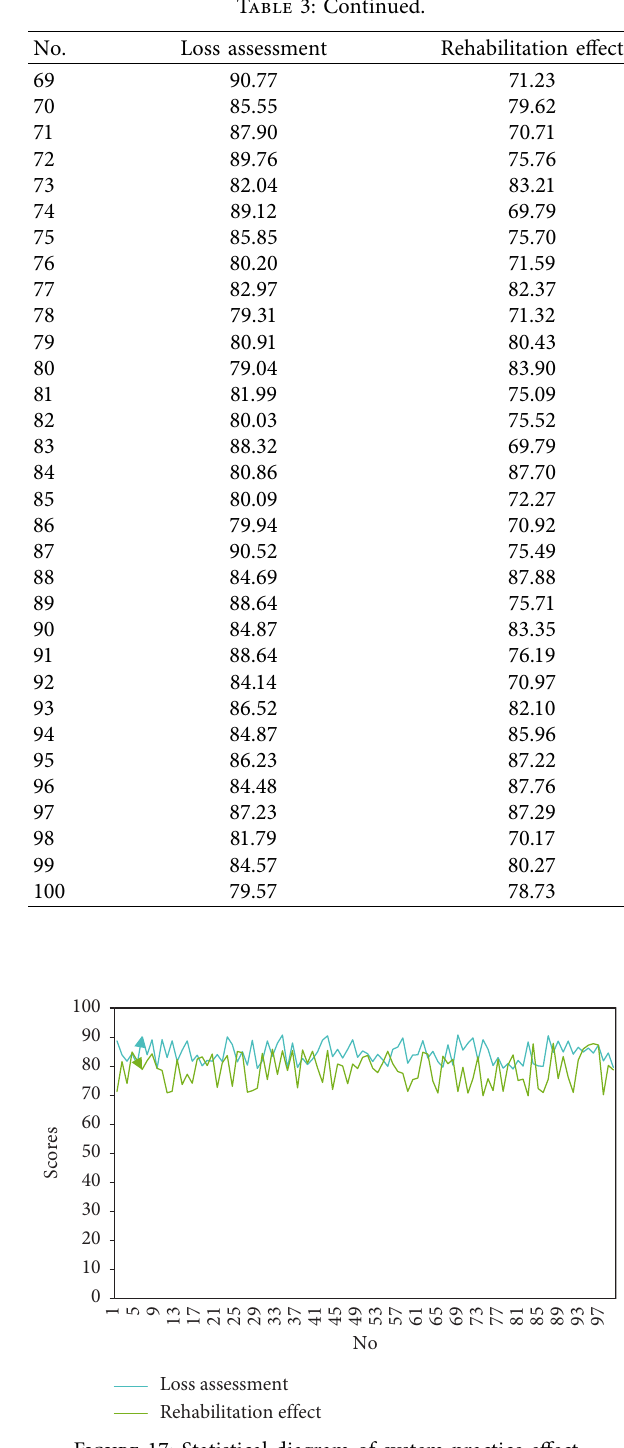
Figure 17: Statistical diagram of system practice